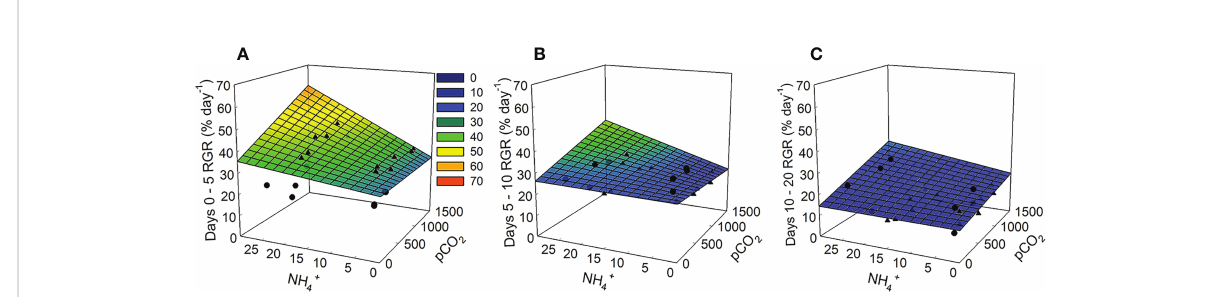
FIGURE 3 Modeled relative growth rates for Ulva lactuca over time based on responses to pCO 2 and NH 4+ treatments in laboratory experiments. (A) Days 0-5 (B) Days 5-10 (C) Days 10-20. The linear expression y= b 0 +( b 1 *x 1 )+( b 2 *x 2 )+( b 3 *(x 1 *x 2 )), where x 1 = pCO 2 and x 2 = NH 4+ , was used to fi t model surface with conventional regression coef fi cients using weighted model-averaging (see Table 2). Overlaying the modeled mesh plots are the RGRs (% day -1 ) from each trial where trial 1 is represented by circles and trial 2 is represented by